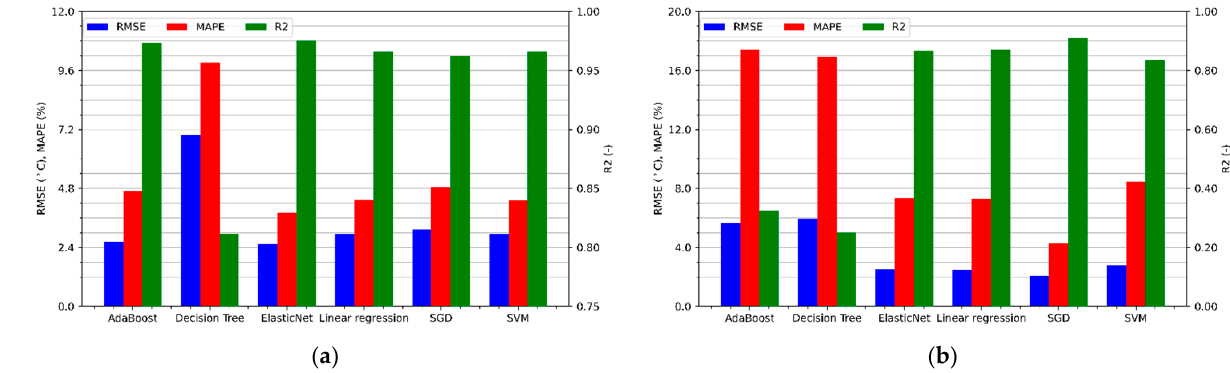
Figure 7. Regression metrics values for the sensorless temperature estimation of the motor: ( a ) without cooling; ( b ) with a cooling fan.